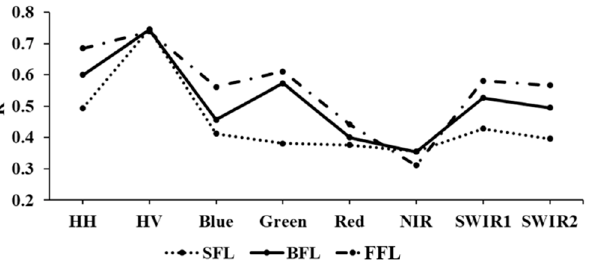
Figure 2. Relationships between satellite data and stem fuel load (SFL), branch fuel load (BFL) and foliage fuel load (FFL). foliage fuel load